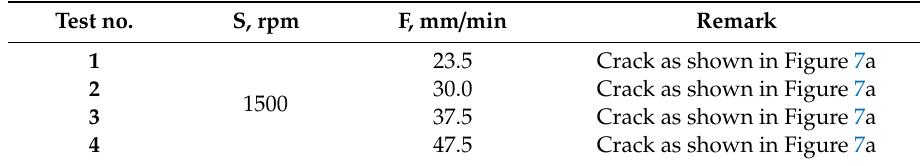
Table 4. Experimental conditions employed to fabricate Cu 1-1060Al lap joints using HSCo-steel tapered-pin tool (T D : 22 s).